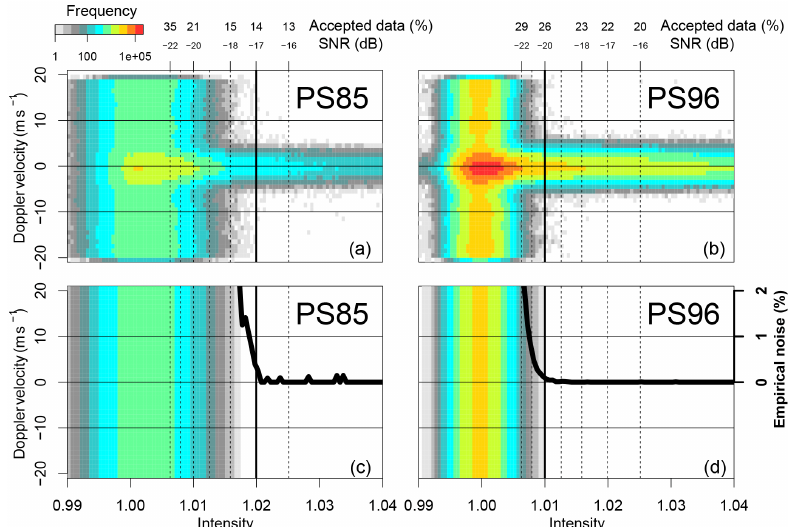
Figure 5. (a, b) Frequency of Doppler velocities of VAD scans with 75 ◦ elevation depending on the intensity/SNR and for PS85 (a, c) and PS96 (b, d) . Bottom row: empirical noise computed as the mean for points above 10ms − 1 or below − 10ms − 1 . The solid black line shows the ratio of empirical noise and all measured data (a, b) at each intensity/SNR. On the top axis it is also noted how much data would be accepted if the respective (minimal) SNR was